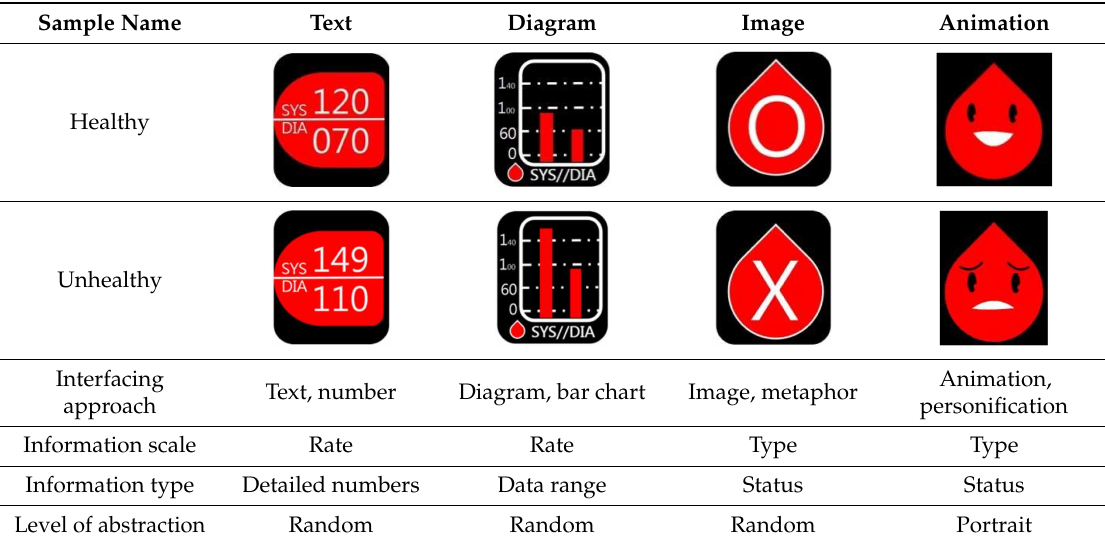
Table 2. Sample design and interface